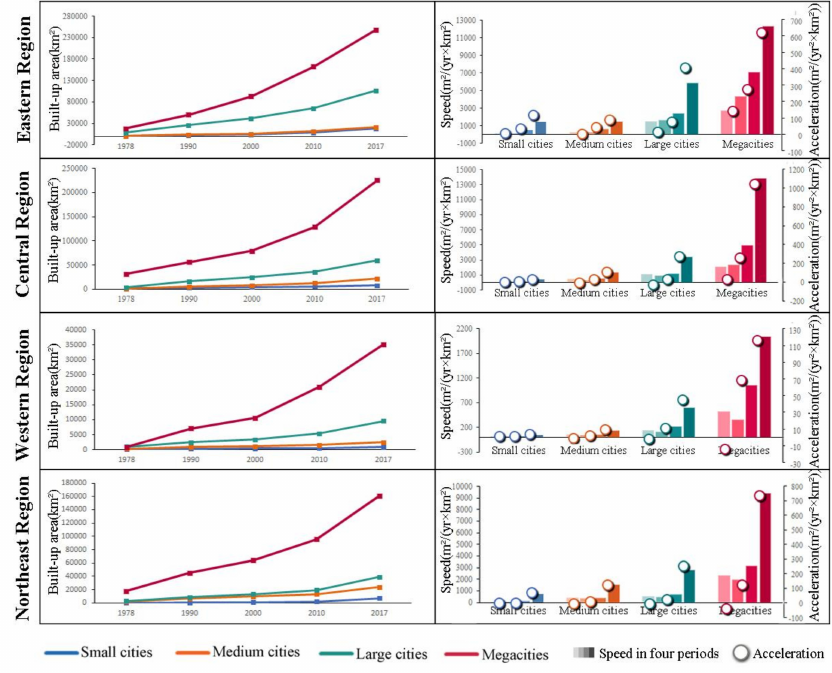
Figure A1. Di ff erences in urban expansion by urban size within di ff erent